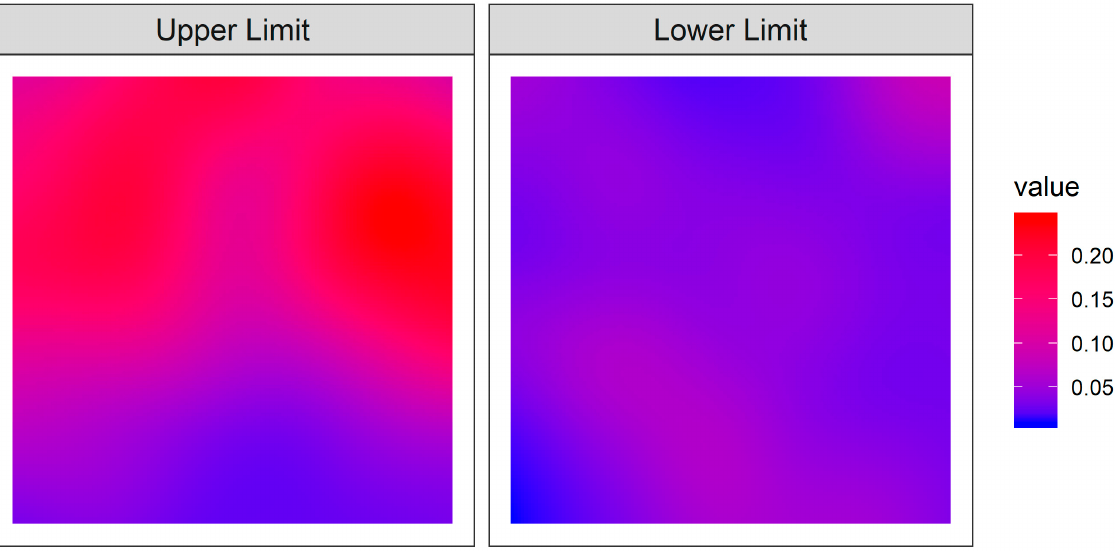
Figure 7. HP null model analysis of spatial patterns of P. armandii , B. albo-sinensis , and B. utilis at the upper limit and the lower limit of the treeline patch. Note: the red points are the g-values beyond the upper envelope at a corresponding scale, the blue points are the g -values under the lower enve- lope at a corresponding scale. 3.3.3. Homogeneous Thomas (HT) Null Model Analysis Observations from g( r ) values and GoF test values (Table 3) showed the difference between the observed line and fitted expected line was significant ( p < 0.05) only for P. armandii at the upper limit, where many of the g( r ) values of P. armandii were greater than g -values of the upper envelopes at r < 15 m scales. The results of the GoF test at the lower